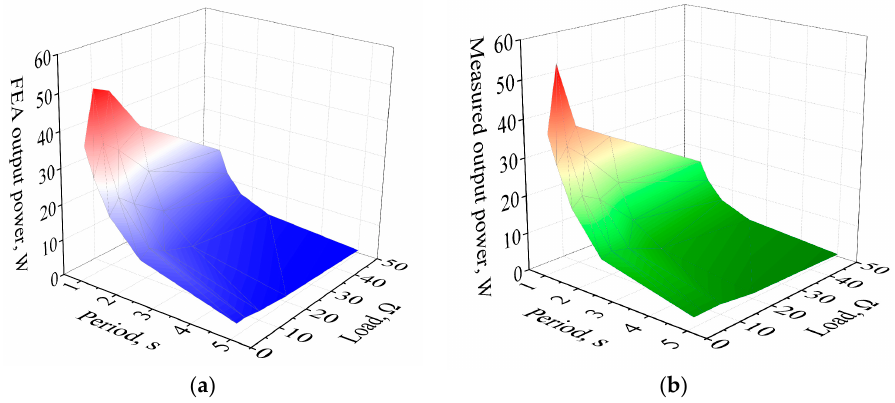
Figure 16. The measured and simulated average output power for MI-TLPMG: ( a ) FEA results; ( b ) measured results.